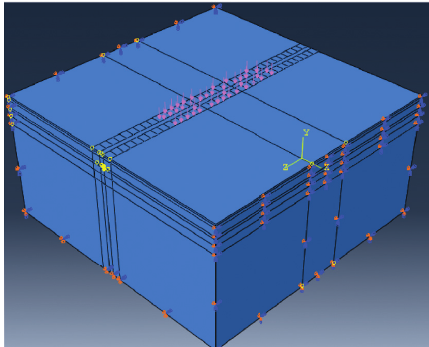
Figure 13: Subgrade FEM model. Figure 14: Boundary